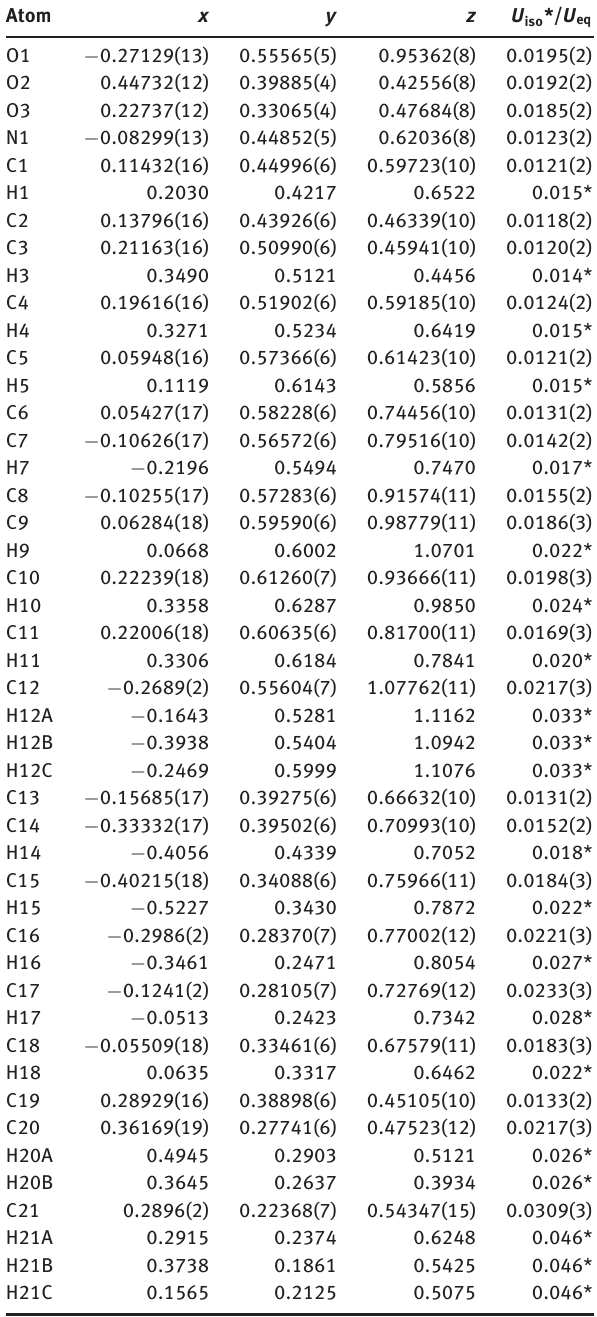
Table 2: Fractional atomic coordinates and isotropic or equivalent isotropic displacement parameters (Å 2